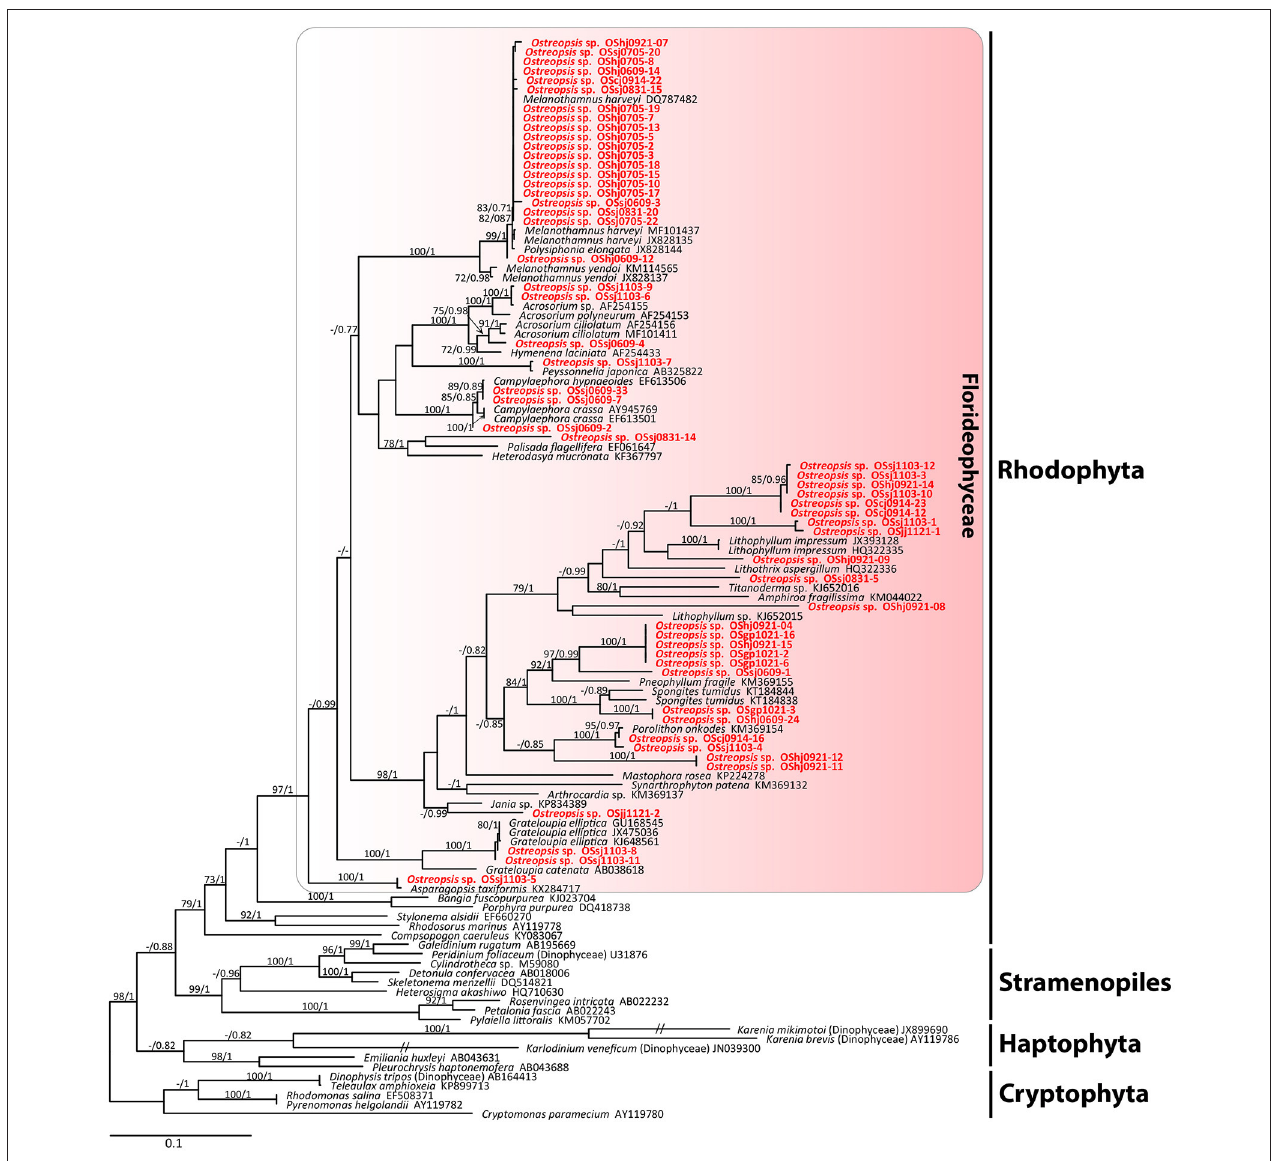
FIGURE 6 | RAxML tree inferred from rbc L sequences of 1,390 sites and representing 115 taxa including Rhodophyta, Cryptophyta, Stramenopiles, and Haptophyta. Sequences from the ingested food particles of Ostreopsis cells isolated from this study are indicated in bold face. Bootstrap value ( > 70%) from maximum likelihood and a Bayesian posterior probability of 0.7 or greater are indicated at nodes. Double slash marks indicate shrink nodes length